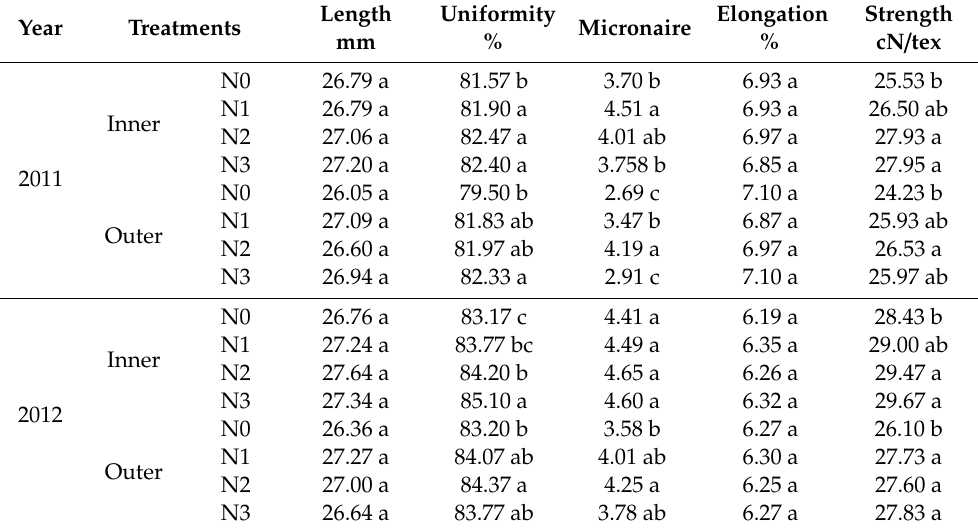
Table 2. Fiber quality in cotton fertilization rate studies conducted in the Yellow River Basin of China in 2011 and 2012.